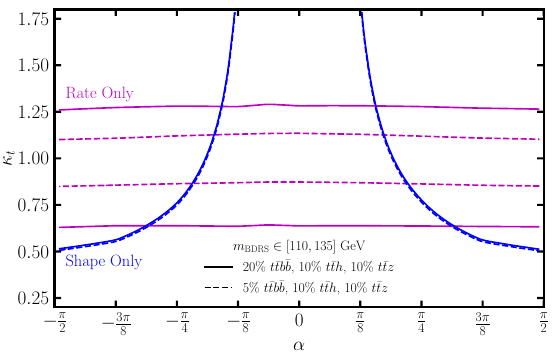
Figure 5 . The individual exclusion at 68% CL from the rate-only measurement (magenta) and shape-only measurement (blue) for two different assumptions on the systematic uncertainty for t ¯ tb ¯ b , 20% in solid and 5% in